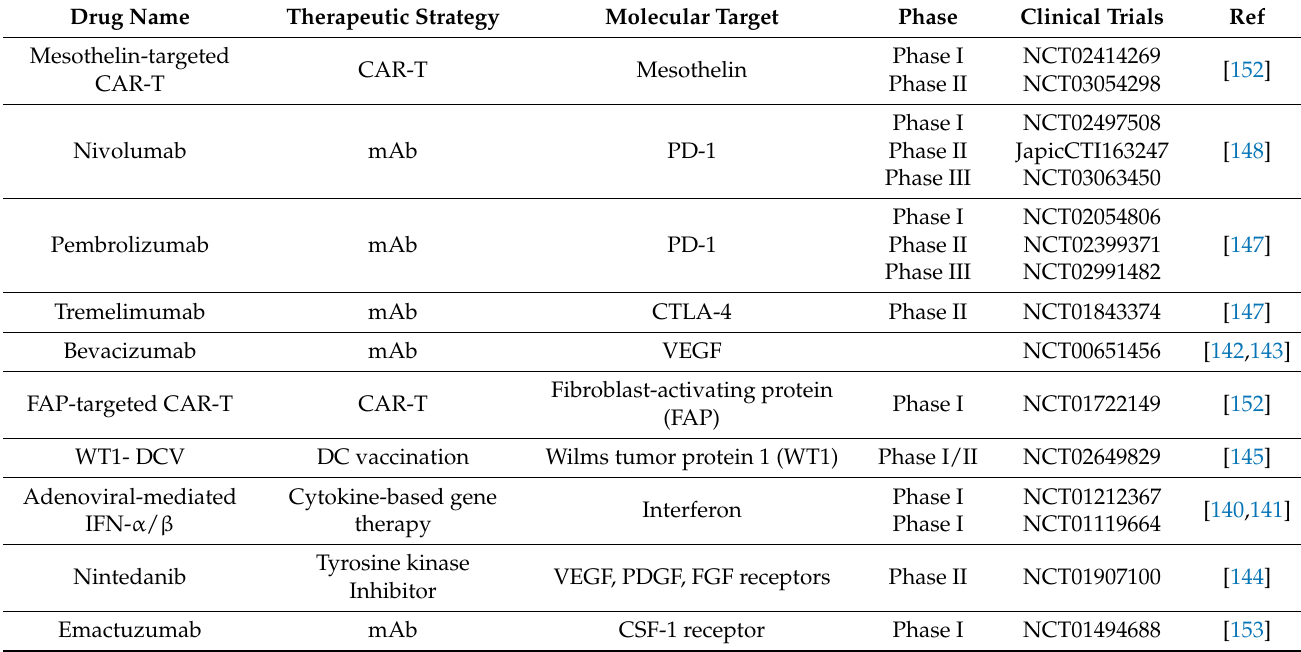
Table 1. Agents targeting mesothelioma microenvironment in clinical